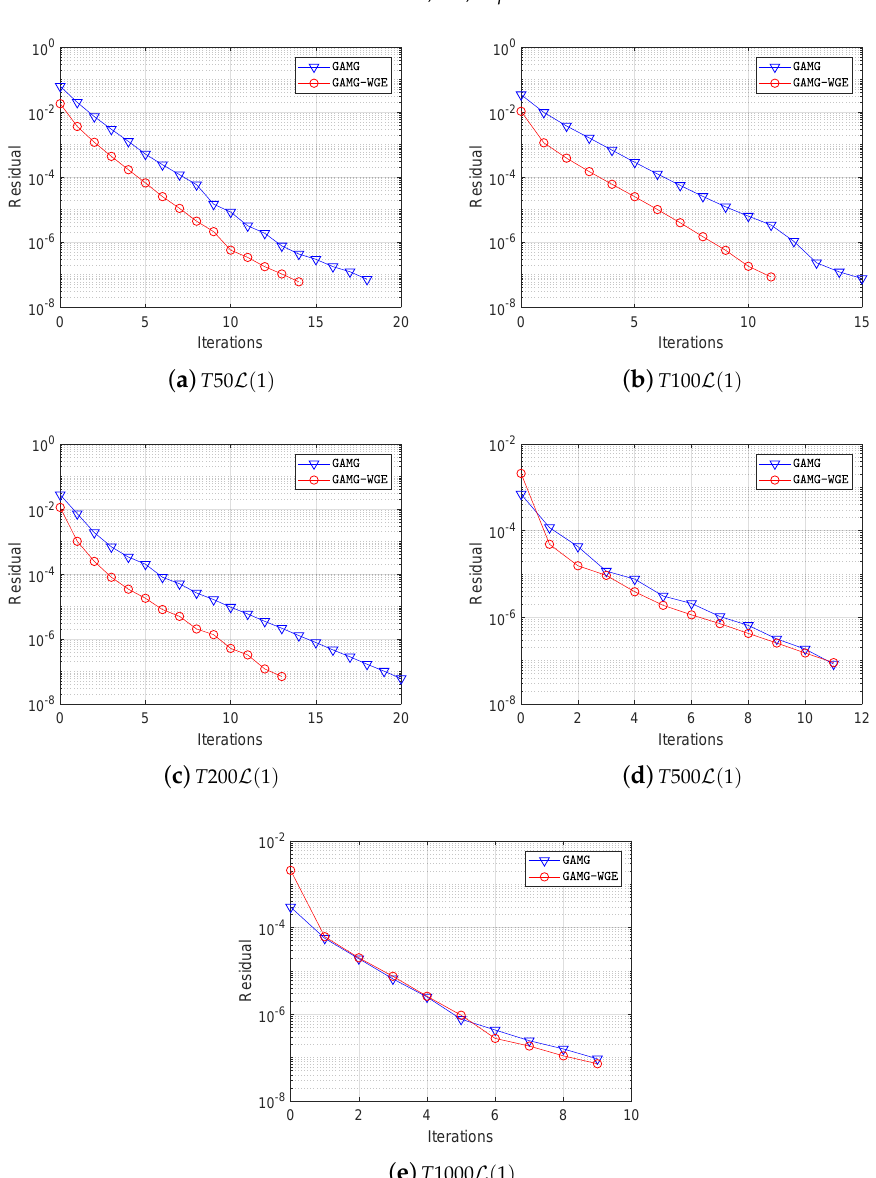
Figure 6. The residual history of the specific linear equation system in